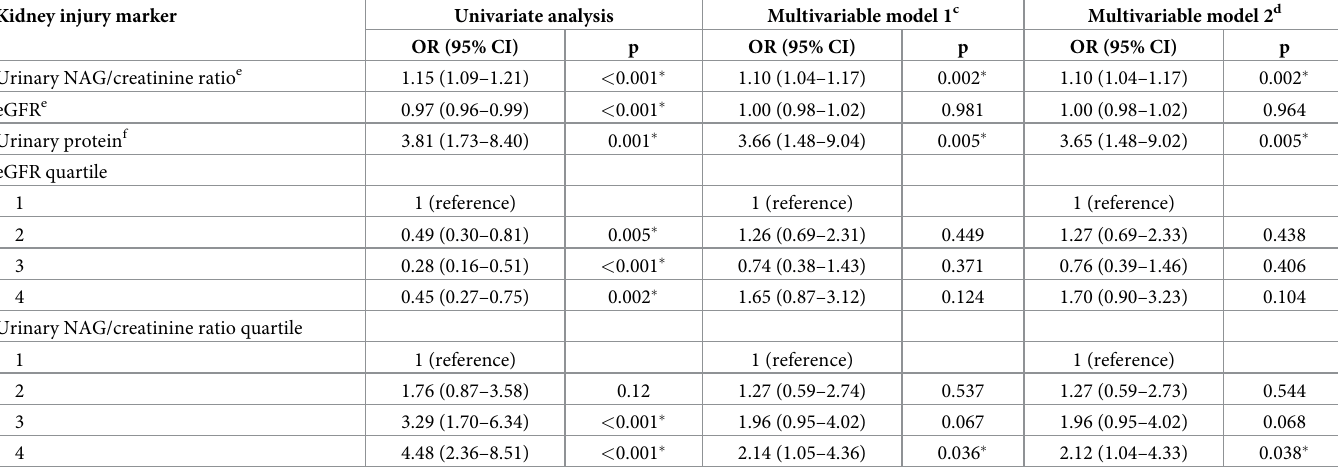
Table 4. Univariate and multivariable-adjusted odds ratios (ORs) a for subsequent disability, by kidney injury marker b